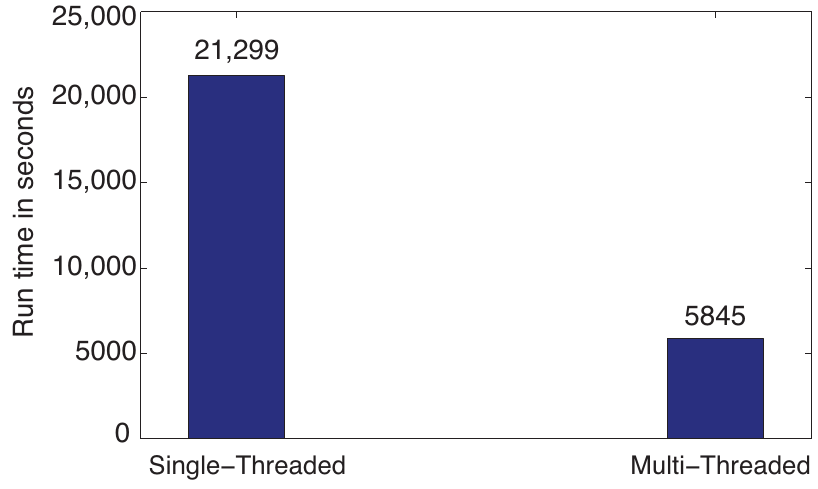
Figure 14. Effect of parallel computing on inverse distance weighting (IDW) run time using the PM data at the county 2 : 5